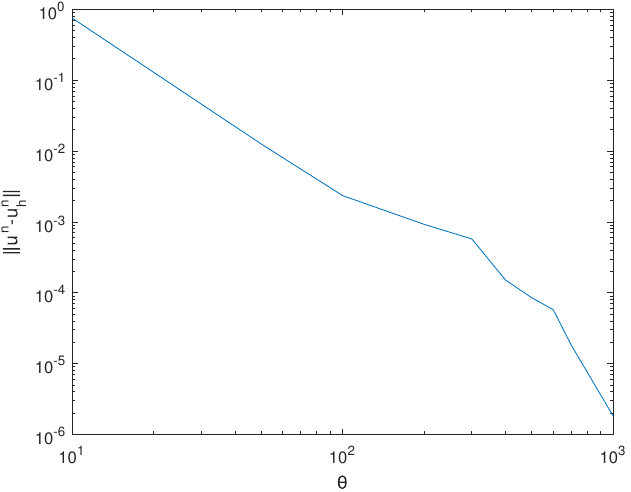
(cid:107) L 2 at mesh 40 and t h